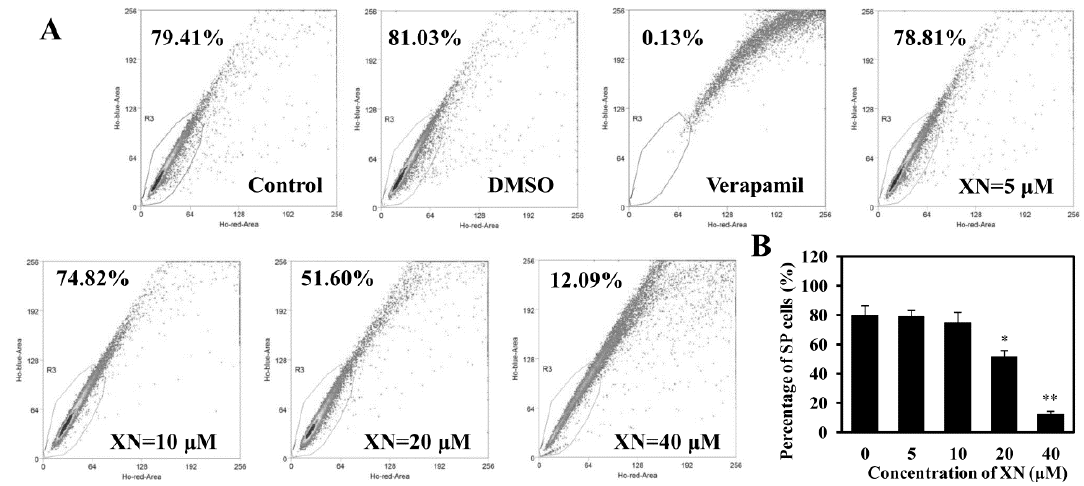
Figure 4. XN inhibits SP cell percentage in MCF-7/ADR. ( A ) A representative result of the SP cell percentage is displayed. After treatment with XN (0–40 μ M) for 48 h, SP cells were counted by flow cytometry using Hoechst 33342 staining. Verapamil was used to set the SP gate; ( B ) histograms show the decreasing percentage of SP cells. Data shown are the means ± SD of three experiments for each group. * p < 0.05, ** p < 0.01 versus medium control.